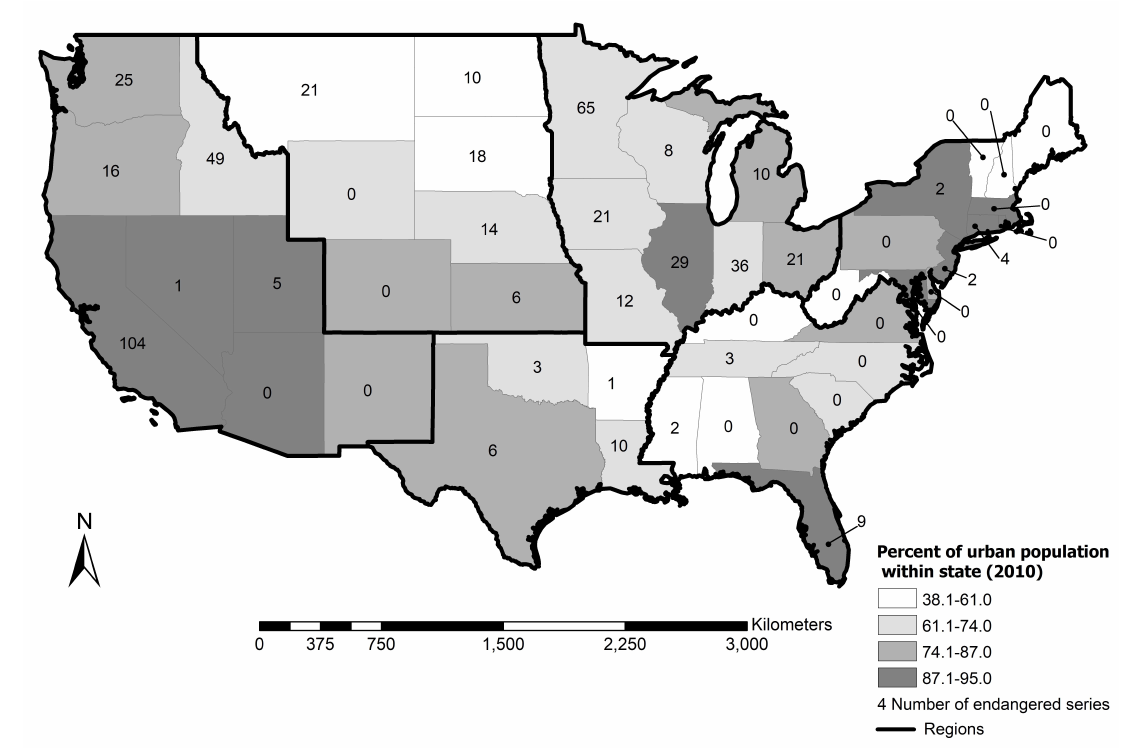
Figure 6. Number of endangered soil series [2] and percent of the urban population within each state (2010) [61] in the contiguous United States (U.S.).